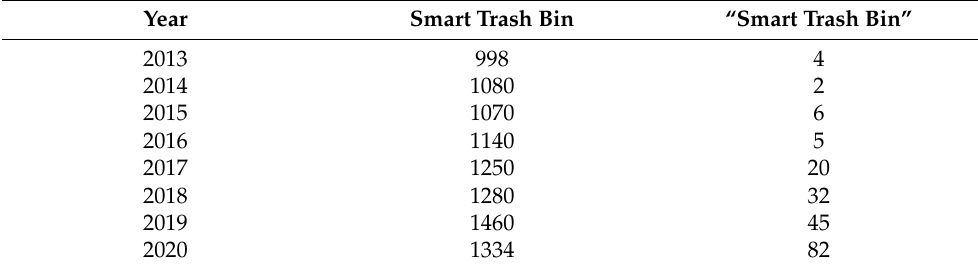
Table 2. The Number of Papers with the Keywords Smart Trash Bin and “Smart Trash